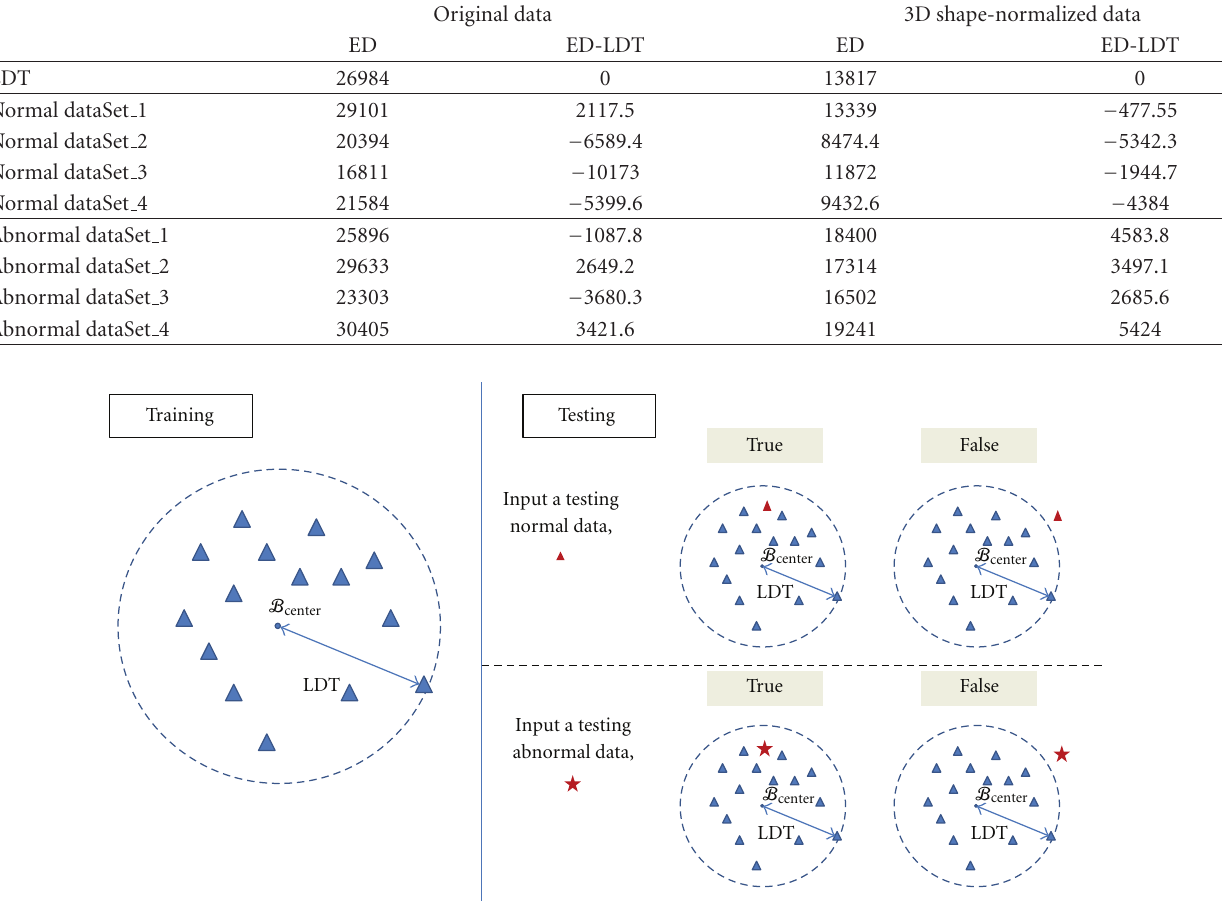
Table 1: Euclidean distances of features.